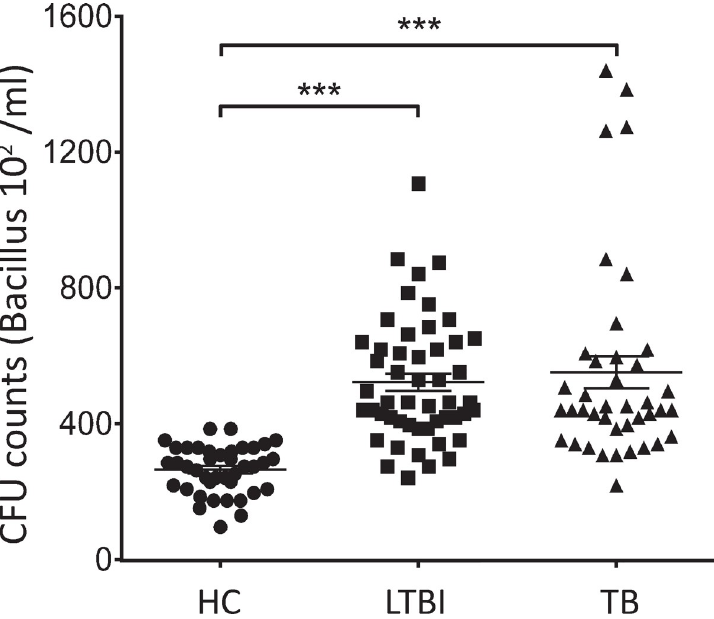
Fig 3. Whole blood microbicidal activity is significantly reduced on both LTBI individuals and active TB patients. Data represent Colony Forming Units (CFU/mL) counts for all the strain and clinical isolates (H37Rv, S1, S5, R3 and R6) in healthy control (n = 10), LTBI (n = 10), and TB (n = 6) groups. Bar indicates the median of CFU/mL counts. Statistical relevance ( ��� = p < 0.0001) was assessed using ANOVA test. CFU = Colony Forming Unit